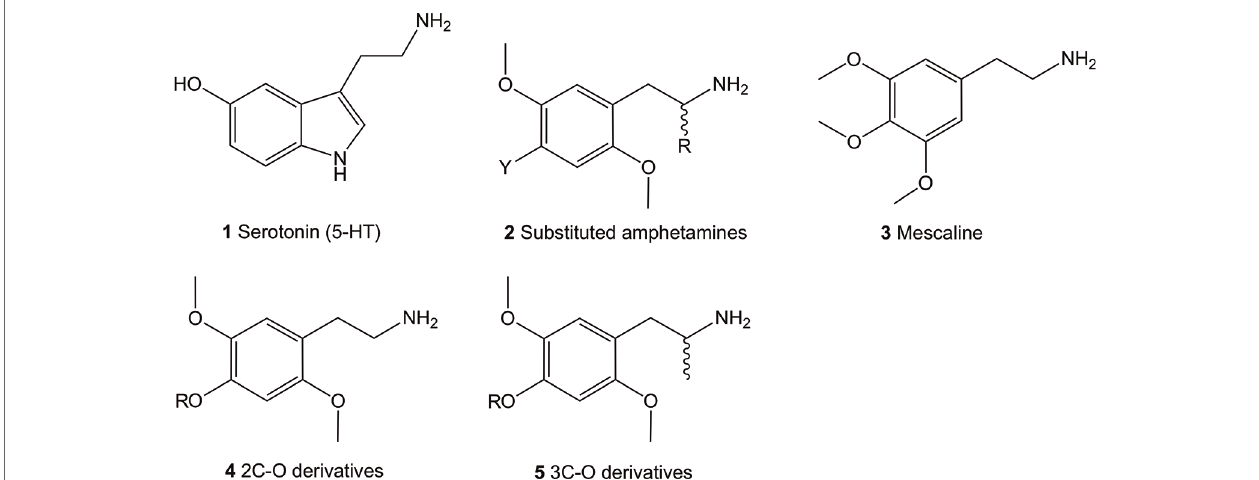
FIgURe 1 | Chemical structures of 5-hydroxytryptamine (5-HT; 1 ), 2,5-dimethoxy-4-substituted phenethylamines ( 2 ), 3,4,5-trimethoxyphenethylamine (mescaline; 3 ) and the general structure of the 4-alkoxy-2,5-dimethoxyphenethylamine ( 4 ) and 4-alkoxy-2,5-dimethoxyamphetamine ( 5 ) compounds. All amphetamines contain the phenethylamine core.